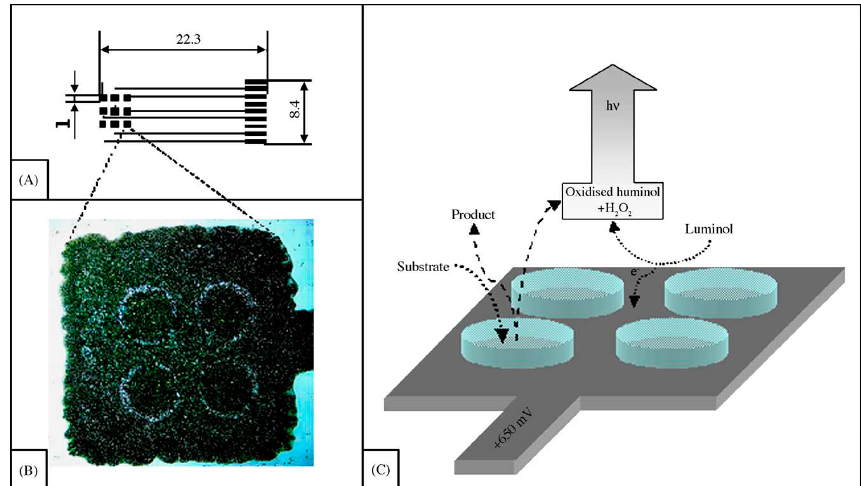
Figure 8. SPE multi-parametric glucose and lactate ECL Biosensor developed by Corgier, B.P. et al. [121]. ( A ) Schematic representation of the nine screen-printed array for ECL measurements. Size in mm. ( B ) Optical micrograph of the electrode surface (1 mm × 1 mm) supporting the four spots sensing layer. ( C ) Schematic representation of the sensing layer organization which is formed by a hybrid layer of photopolymer-Sepharose beads PVA-SbQ and reaction at a carbon electrode surface (1 mm × 1 mm). Reproduced and adapted with permission of Elsevier.